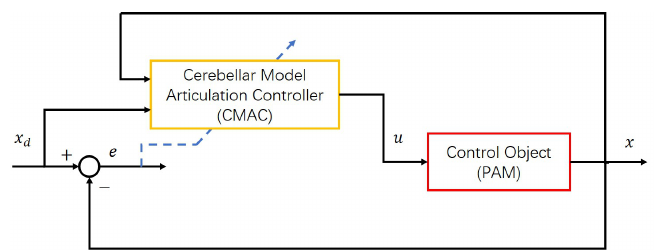
Figure 9. Adaptive motion controller by CMAC for